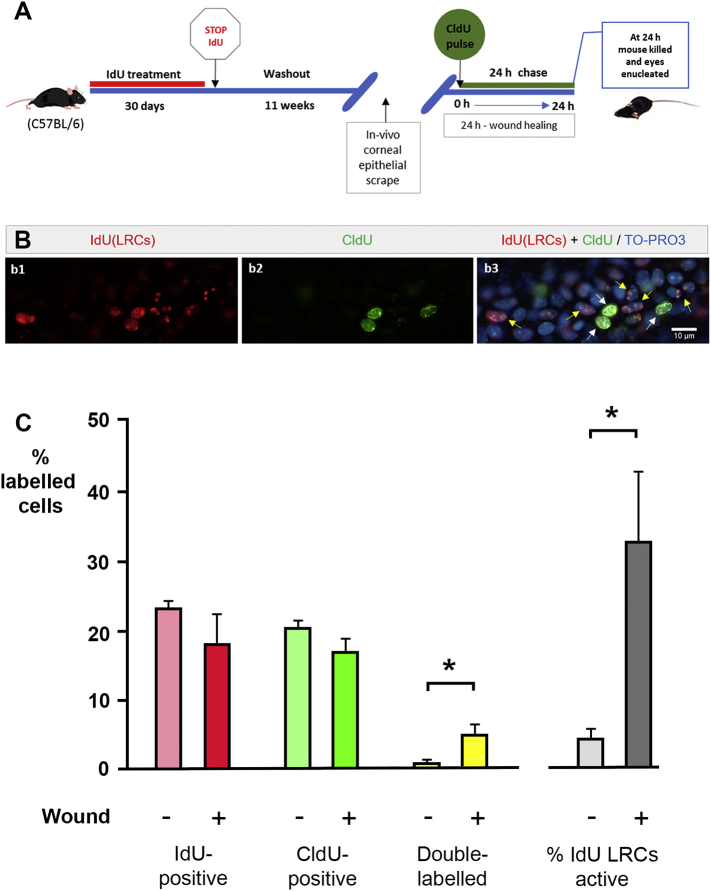
Activity of label-retaining cells in limbal epithelia 0–24 h after corneal wounding. (A) Schematic representation of a pulse-chase-pulse experimental design illustrating the exposure of 8 week-old C57BL/6 mice to 30 days IdU treatment, subsequent 11-weeks washout, CldU injection at 0 h after unilateral corneal epithelial wound in vivo, and mice death at 24 h. (B) Immunofluorescent images of proliferative cells in flat-mounted idU-labelled limbal epithelium after wounding and CldU pulse: (b1) IdU (red); (b2) CldU (green); (b3) Merged image including TO-PRO3-label (blue). Double-labelled cell indicated by white arrows are actively proliferative label-retaining cells. Yellow arrows indicate IdU-positive, CldU-negative (stem) cells that did not divide after wounding. (C) Cell proliferation in the limbal epithelia of unwounded and wounded corneas. Data are expressed as mean ± SEM of: %IdU-positive cells as a proportion of all cells in limbal epithelium – pink/red), %CldU-positive cells (green), and % of double-labelled cells (yellow) 24 h after wounding. Grey bars show the % of double-labelled cells as a proportion of the IdU-positive cells and represents the percentage of label-retaining stem cells that were dividing in wounded and unwounded eyes. There was a significant sevenfold increase in the percentage of label-retaining stem cells entering mitosis in wounded eyes (P < 0.05 (*), Mann–Whitney U test, n = 6 wounded, 6 unwounded. (For interpretation of the references to colour in this figure legend, the reader is referred to the web version of this article.)